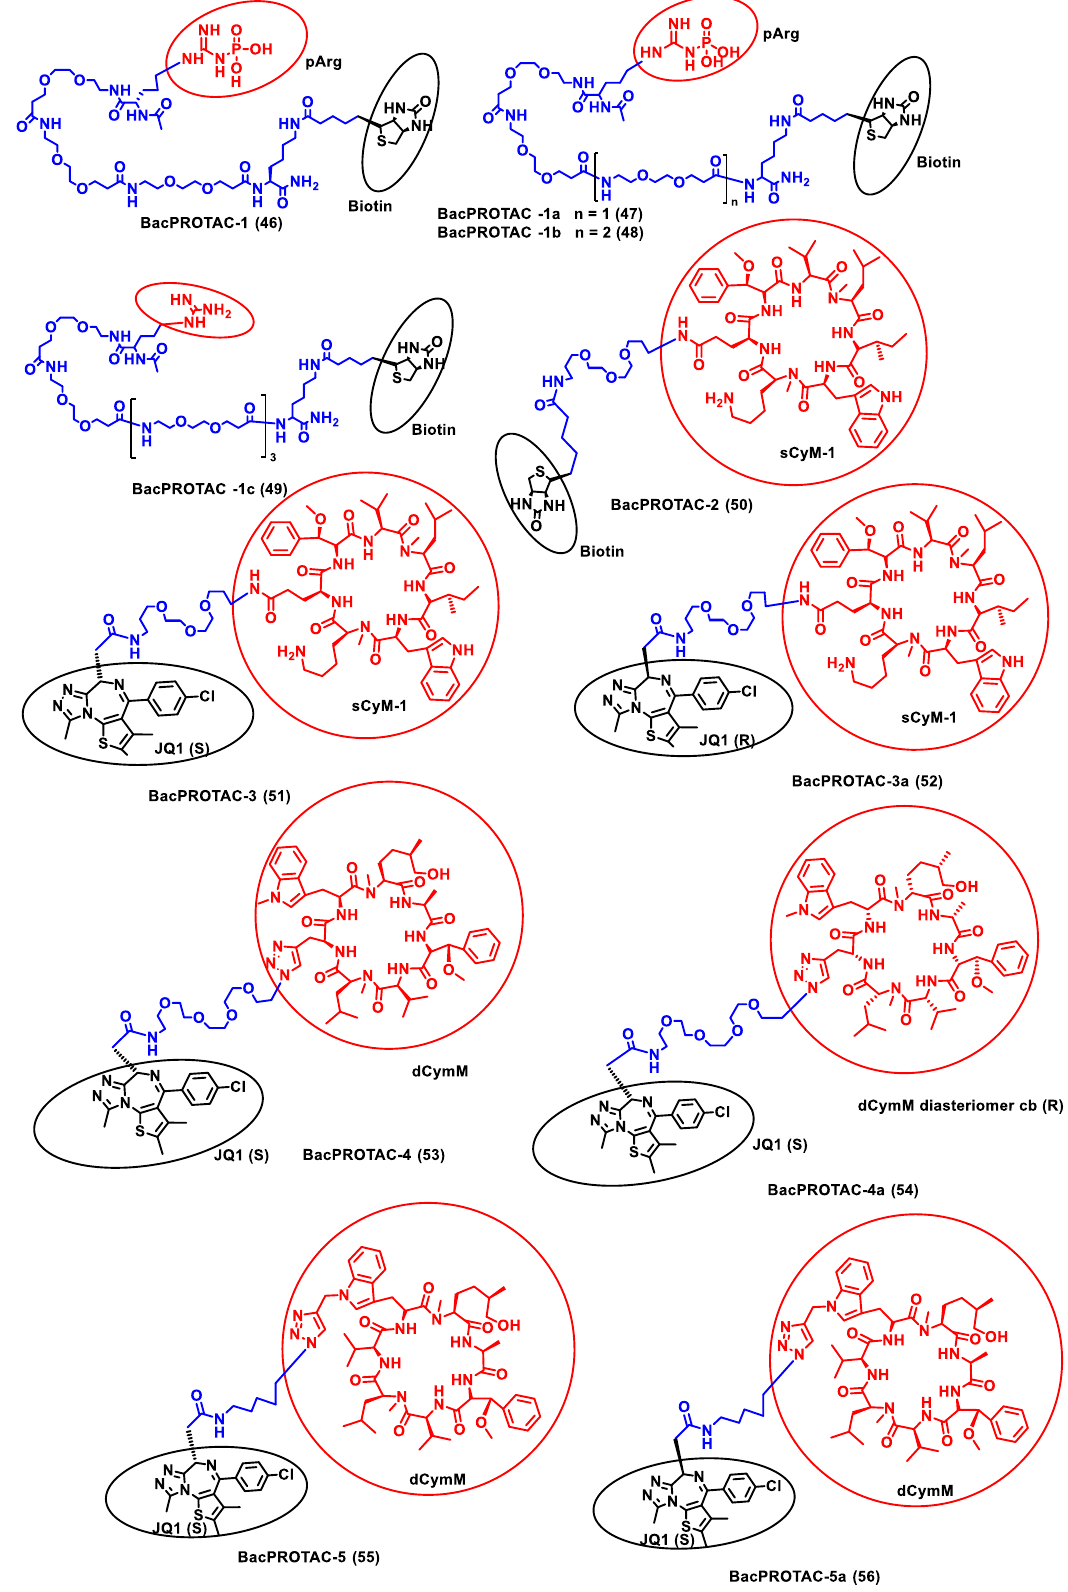
Figure 7. Structures of the PROTAC molecules are used for the degradation of proteins in prokaryotic cells using a bacterial proteolysis system. The red circle indicates the POI ligand. The Blue wavy line indicates the linker, and the black circle indicates the E3 ligand moiety.